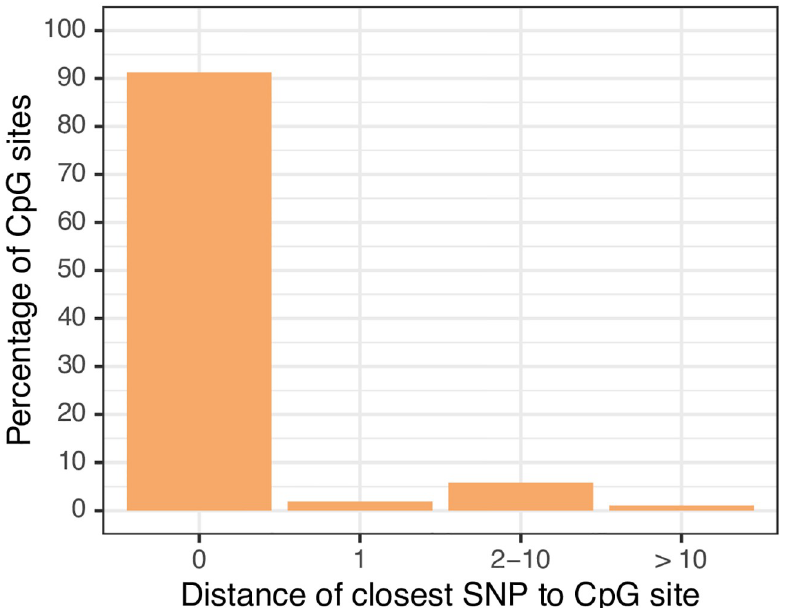
Fig 5. Positions of known SNPs in probe sequences of correlated probes. 1,507 of the 1,513 significantly correlated probes have known SNPs in their probe sequence. The vast majority of these ( > 90%) map to the CpG site